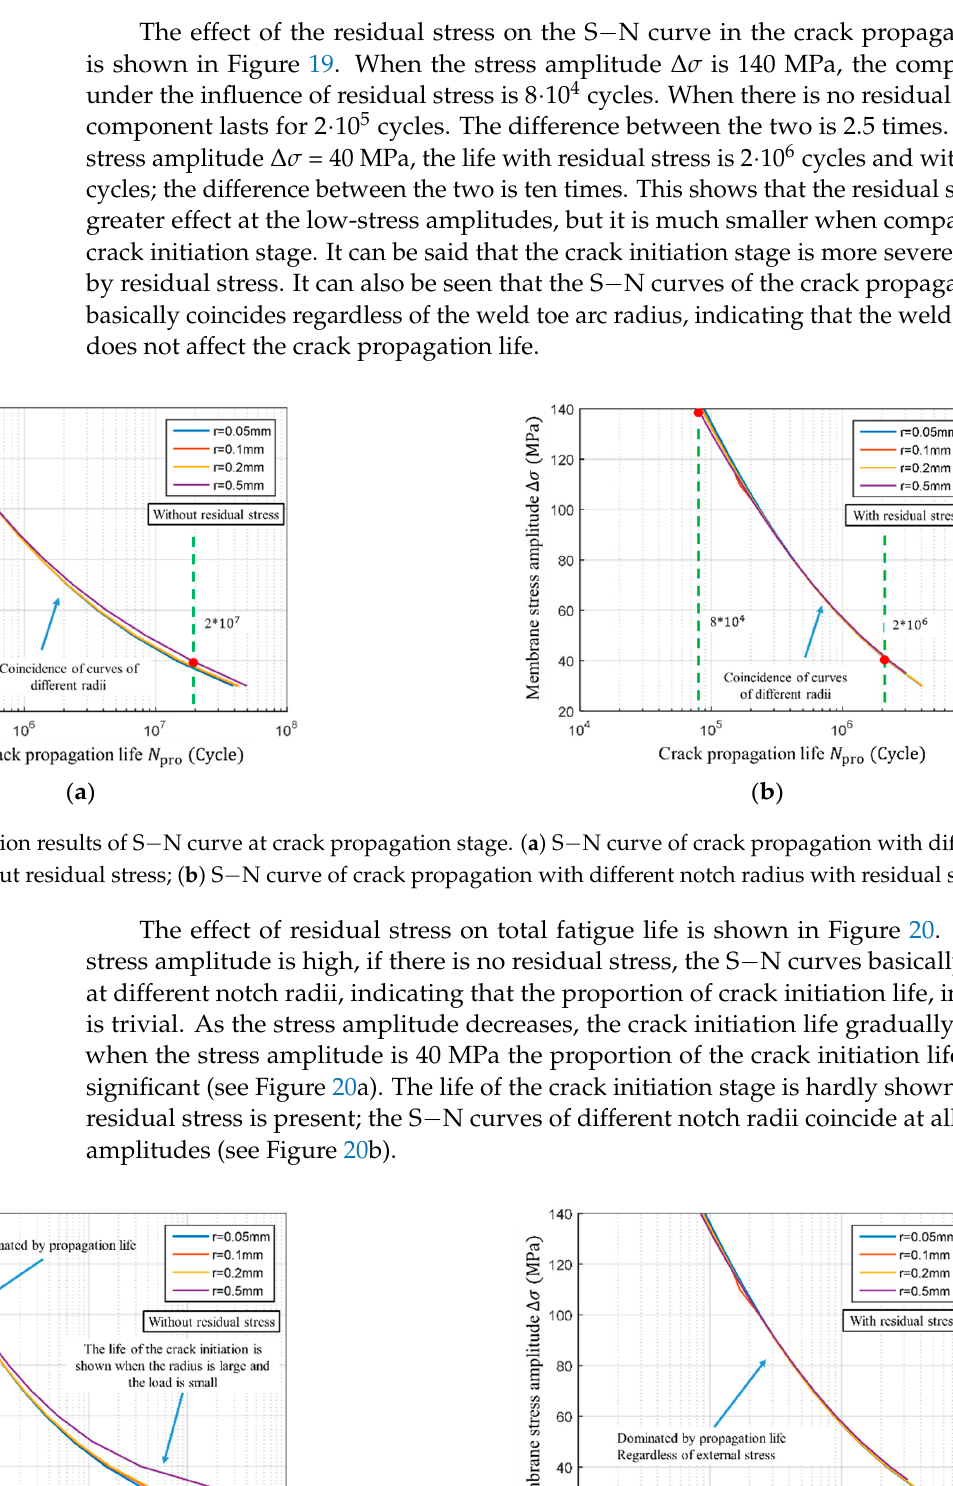
Figure 18. Results of S − N curve at crack initiation stage. ( a ) S − N curve of crack initiation with different notch radius without residual stress; ( b ) S − N curve of crack initiation with different notch radius with residual stress.